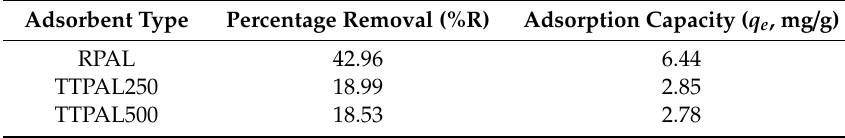
Table 2. Performance of PAL—based adsorbents in terms of %R and q e . Testing adsorption performance was conducted using a variable blend of pH = 7.00 ± 0.20, DC = 50 ppm, AD = 50 mg / 15 mL, CT = 30 min. The responses shown were calculated using Equations (1) and